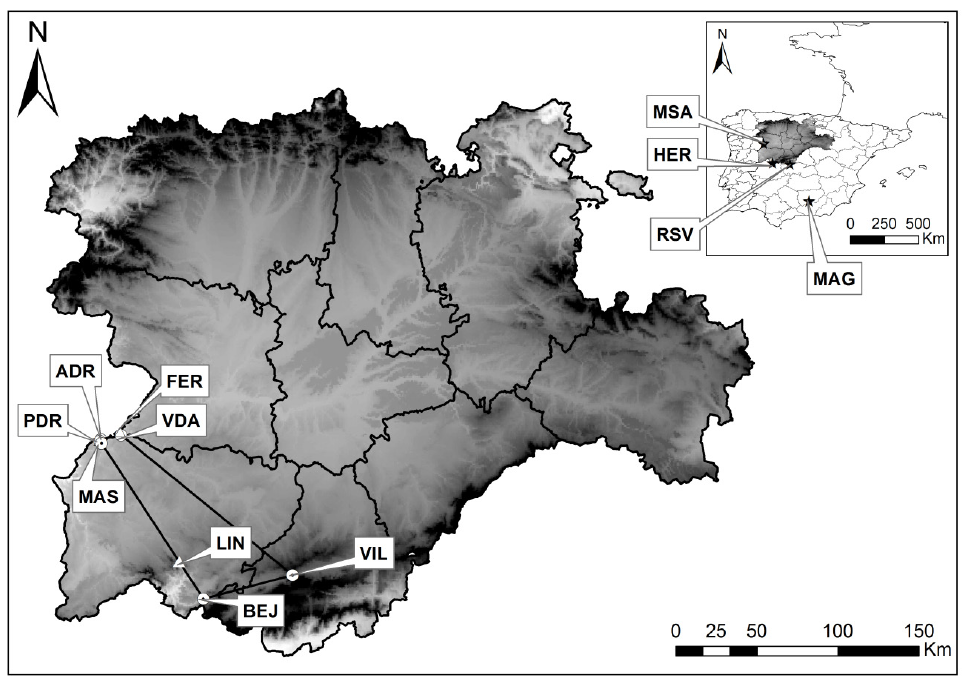
Figure 1. Location of Castile and Leon within Iberian Peninsula which is situated in the southwestern Europe. The distribution map of Delphinium fissum subsp. sordidum shows the Extent of Ocurrence (EOO) calculated by the Minimum Convex Polygon (MCP). The circle symbol indicates the confirmed subpopulations and the triangle symbol the unconfirmed subpopulations located in Castile and Leon. The rest of subpopulations are represented by a star symbol completing the whole distribution range of the study subspecies.